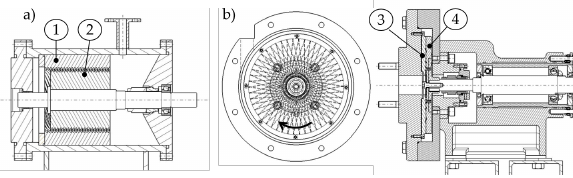
Figure 1: The example of the labyrinth pumps: a) with axial flow, b) with radial flow: Elements: 1 – sleeve, 2 – screw, 3 – passive discs, 4 – active disc